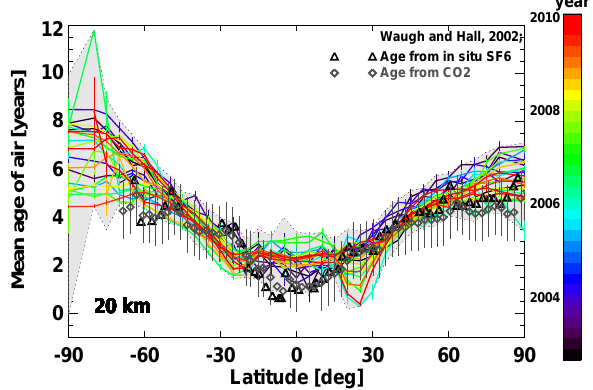
Fig. 5. Latitude-time cross-section of mean age of air at 25km al- titude for the period September 2002 to January 2010. White areas represent regions where no data are